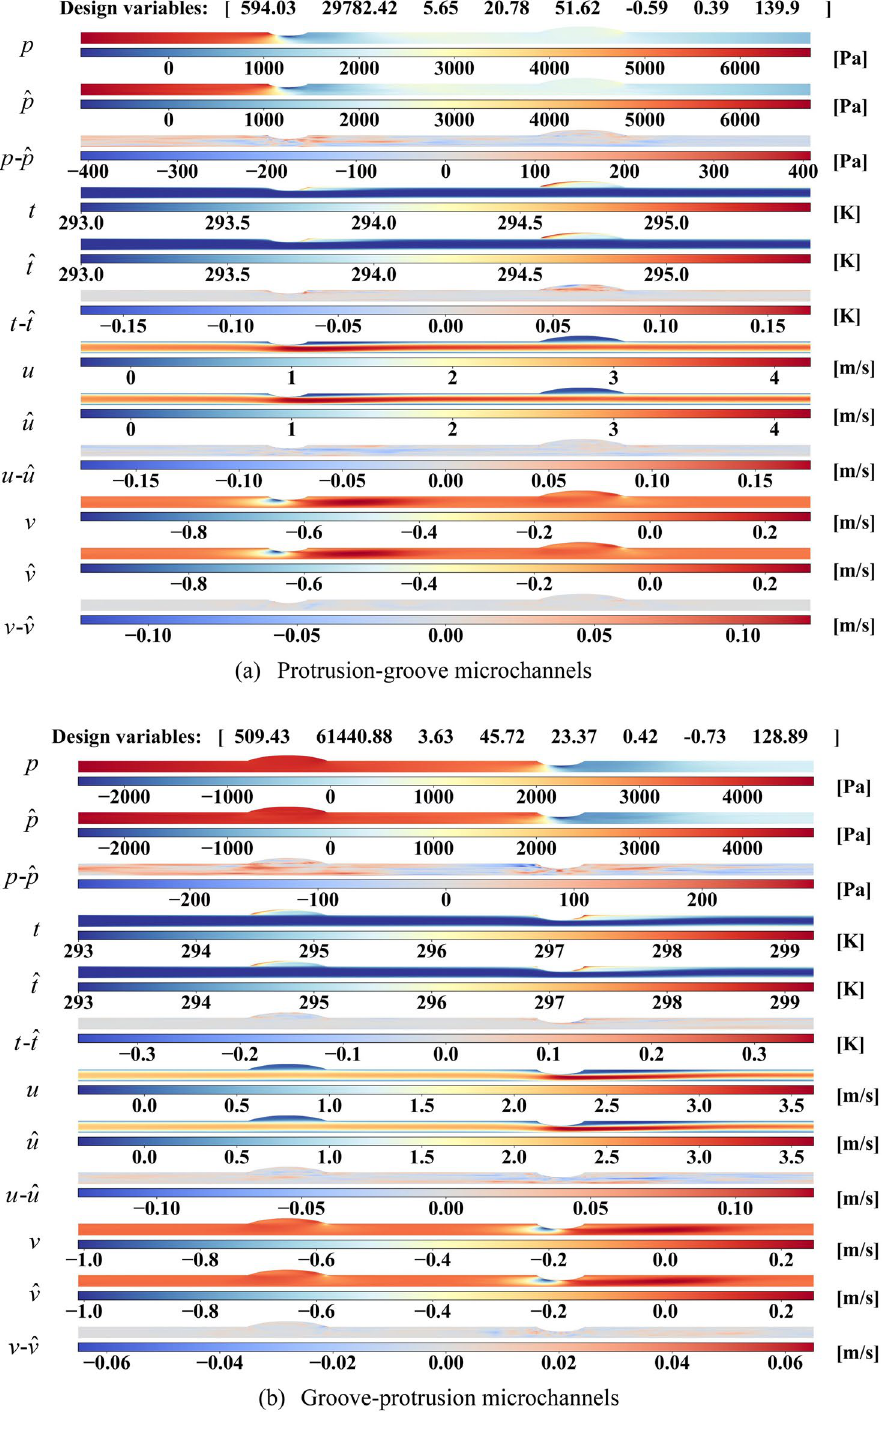
Figure 3. Flow field reconstructions with different geometry (two specific examples for each geometric type of microchannels) and the corresponding ground